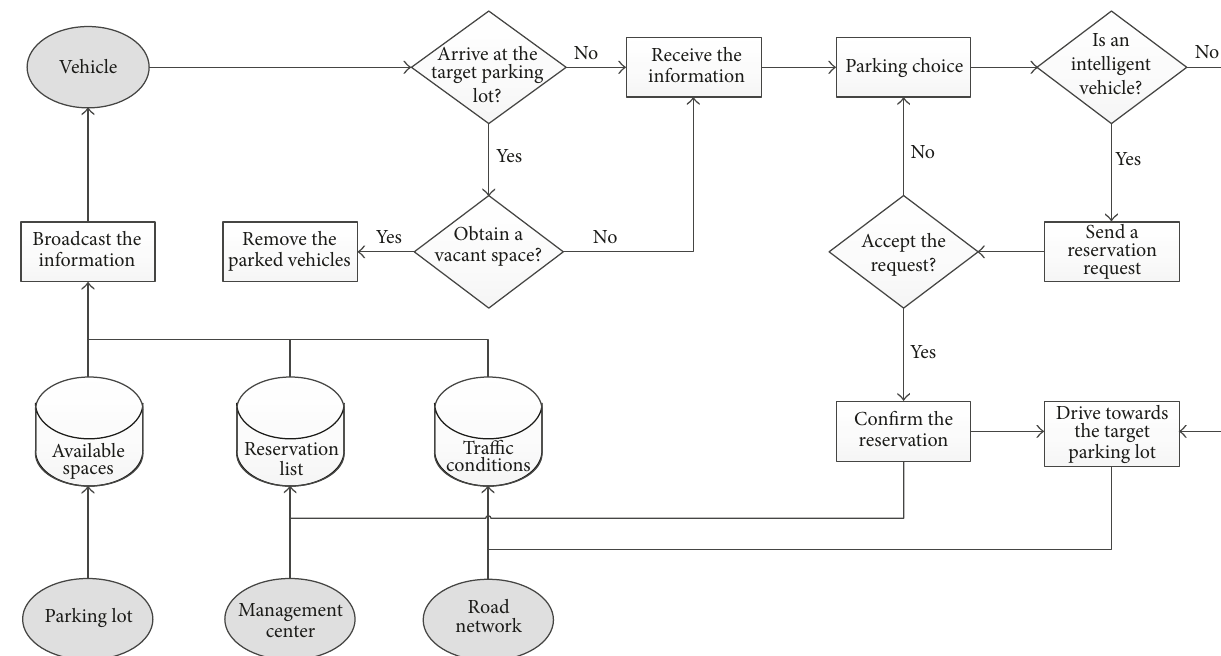
Figure 3: Framework of the agent-based